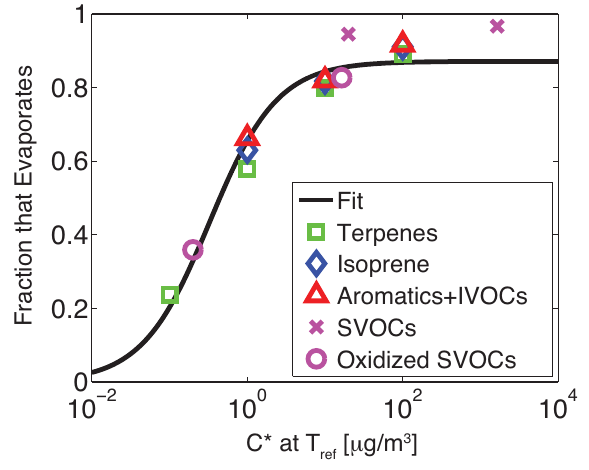
Fig. 4. Fraction of semivolatile mass that partitions to the aerosol phase but later evaporates globally and annually averaged as a func- tion of saturation concentration at the reference temperature. The fit corresponds to a semivolatile that is emitted in region with a load- ing of 2.6µg/m 3 and travels to a region with a loading of 0.3µg/m 3 without any losses. T ref is 298K for all semivolatile species except primary SVOCs and oxidized SVOCs which use 300K.